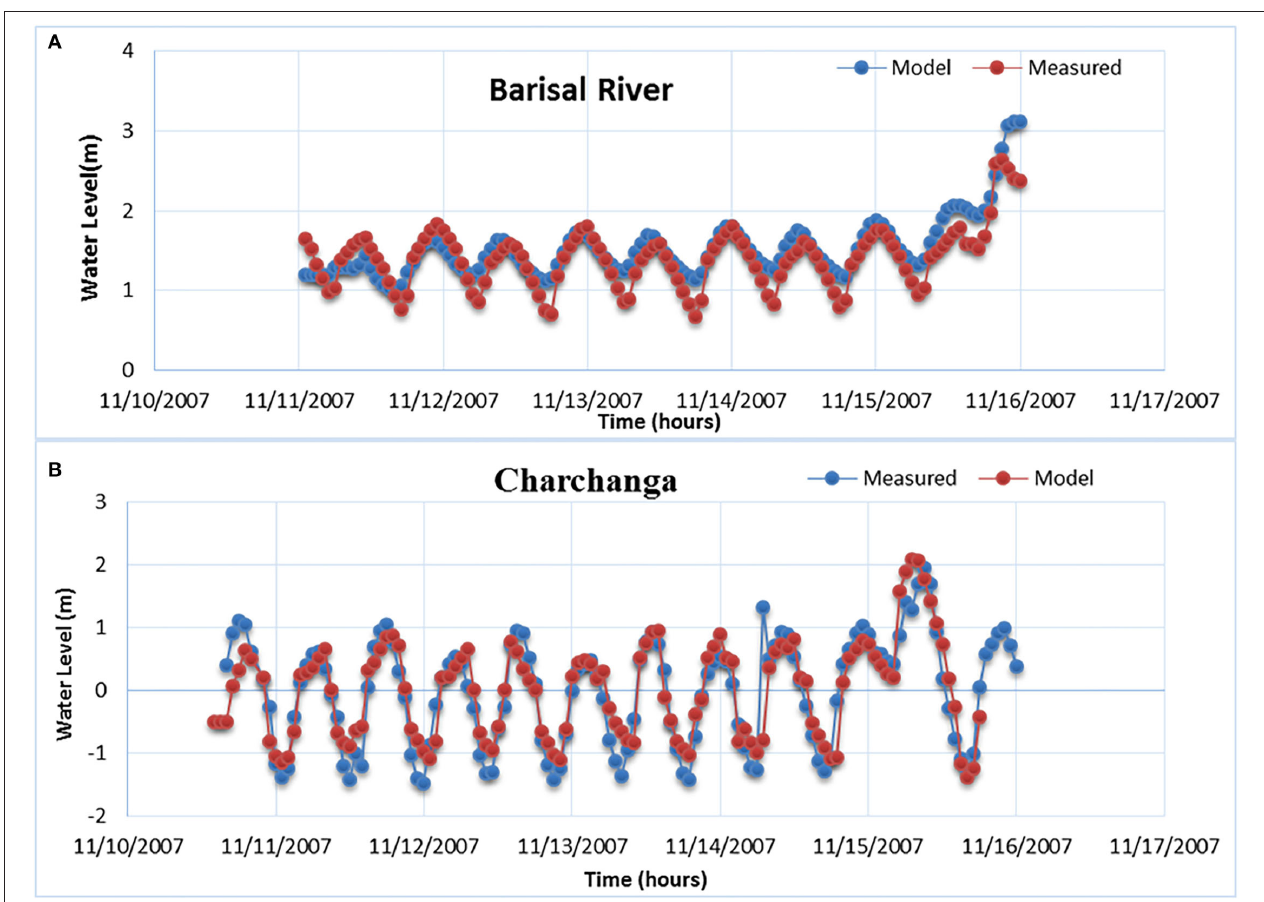
FIGURE 7 | Model validation (comparison between modeled and hourly observed data) for cyclone Sidr at Charchanga (A) and Barisal River (B)